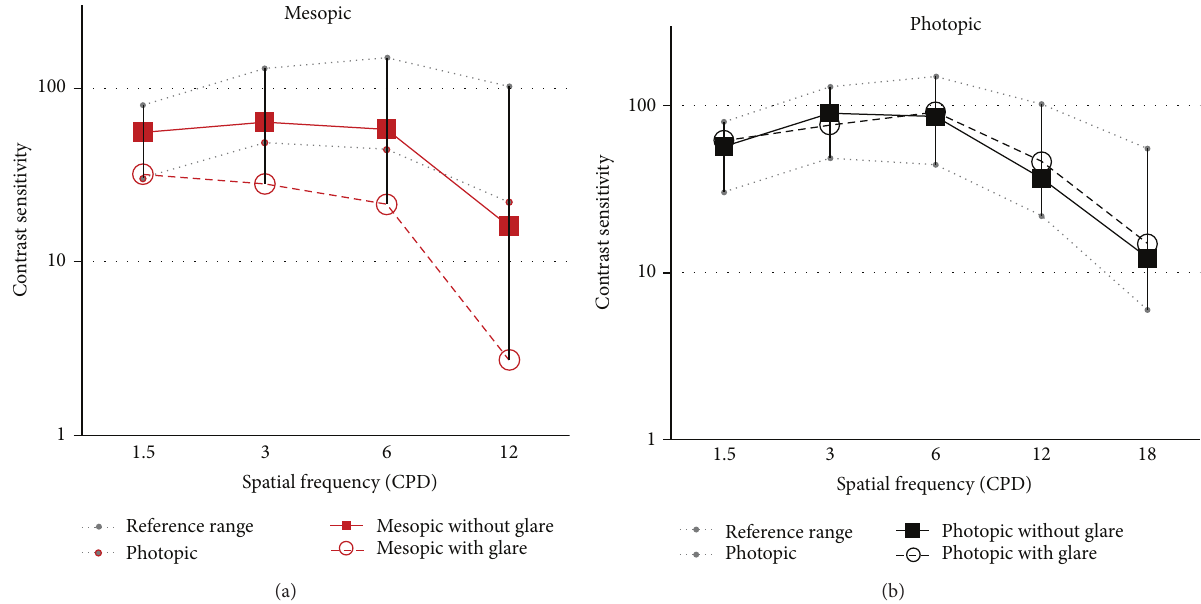
Figure 5: Mean contrast sensitivity function under mesopic (a) and photopic (b) conditions with (dashed line with circles) and without (straight line with squares) a glare source at 3 months after surgery in the analysed